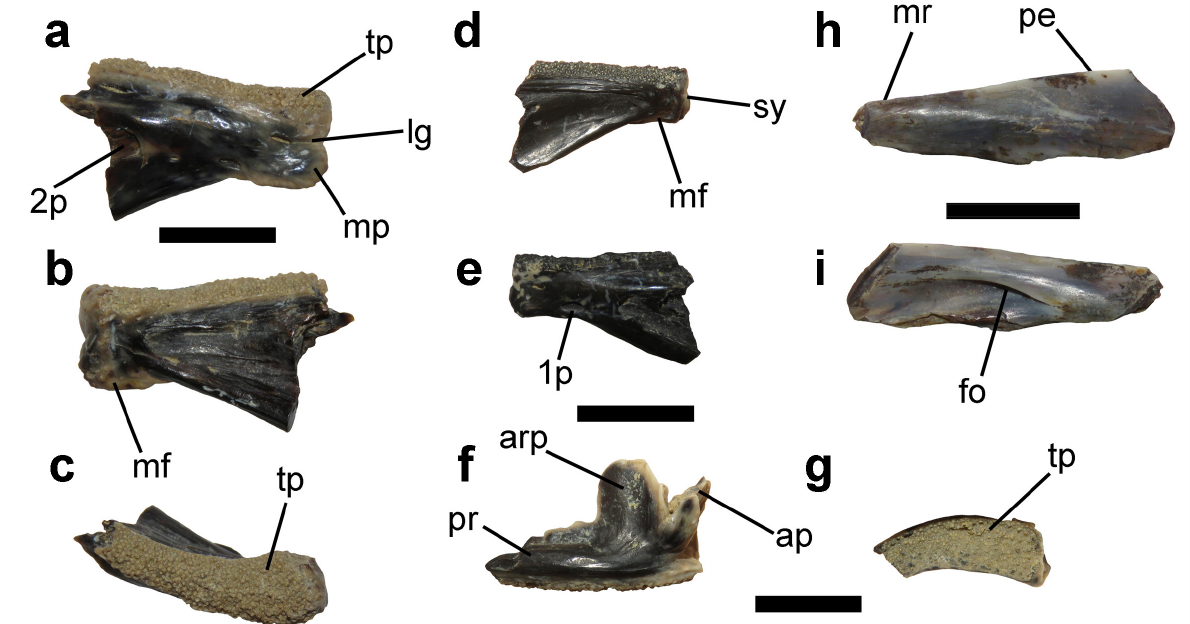
Figure 3. Percichthyidae genus and species indeterminate. Selected cranial bones. a-c, right dentary (LIEB-PV 8003) in a, lateral; b, medial; and c, occlusal views. d-e, left dentary (LIEB-PV 8002) in d, medial, and e, lateral views. f-g, right premaxilla in f, lateral, and g, occlusal views. h-i, left maxilla (LIEB-PV 8002) in h, lateral; and g, medial views. References: ap, ascending process; arp, articular process; fo, medial foramen; lg, longitudinal groove; mf, mentonian flange; mp, mentonian process; mr, maxillary ramus; pe, posterior expansion; pr, premaxillary ramus; sy, dentary symphysis; tp, tooth patch; 1p, first pit for the mandibular sensitive canal; 2p, second pit for the mandibular sensitive canal. Scale bar: 1